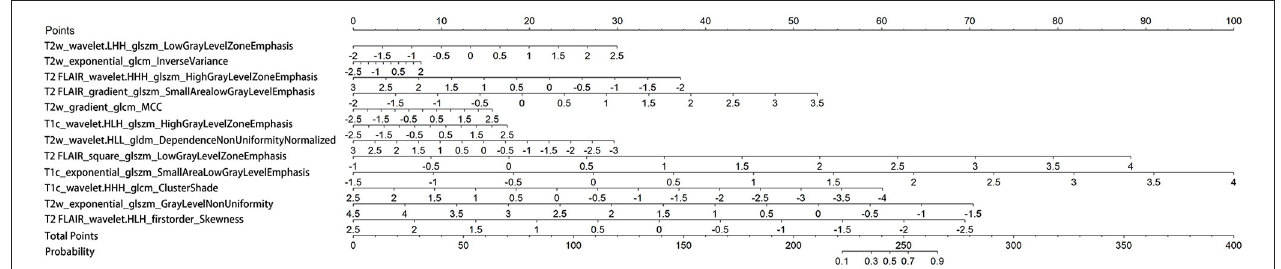
FIGURE 6 | Nomogram of the combined model. A vertical line was drawn from each predictor to the point to obtain the score of the predictor. The scores of each predictor are then added, and a vertical line is drawn from the total score to the survival probability axis. The total score corresponds to the probability of > 12 months